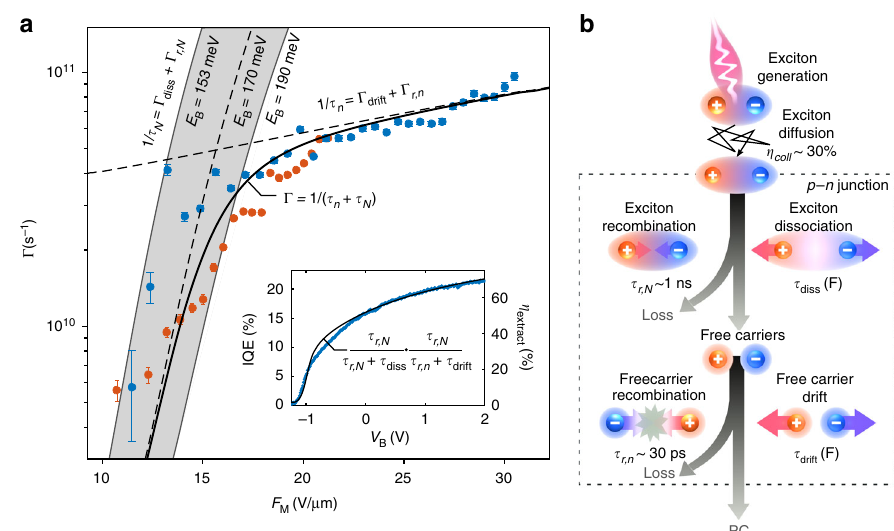
Fig. 4 Dynamic processes governing the photoresponse of monolayer WSe 2 p – n junctions. a Photoresponse rate Γ ¼ 1 τ measured by TRPC (same data as Fig. 3c) vs. maximum in-plane electric fi eld F M calculated for various values of V asym (with V B = 0 V, orange points) and V B (with V asym = 10 V, blue points). ¼ Γ ð F Þ þ Γ ; where τ ¼ 1 = Γ At low fi eld ( F M < 15 V µ m − 1 ), the photoresponse is well described by the total exciton rate Γ N ¼ 1 τ diss M r ; N r ; N r ; N is the exciton N lifetime at zero fi eld ( τ r ; N (cid:3) 1 ns) and Γ diss is the exciton dissociation rate predicted by the 2D Wannier – Mott exciton (see Supplementary Note 4) with a binding energy between E B = 153 and 190 meV (gray shaded curves) and E B = 170 meV (dotted black line). At high fi eld ( F M > 20 V µ m − 1 ), the ¼ Γ ð F Þ þ Γ τ ¼ 1 = Γ photoresponse is governed by the total free carrier rate Γ n ¼ 1 τ drift M r ; n (dotted black line), where r ; n r ; n is the free carrier lifetime at zero n fi eld ( τ (cid:3) 30 ps) and Γ μ = 4 cm 2 V − 1 s – 1 ) drift out of the junction (see Supplementary Note 6). Since r ; n drift is the rate at which carriers (with a mobility exciton dissociation and free carrier drift are consecutive processes, the total photoresponse rate of the device is Γ (cid:4) 1 τ (black solid line). Inset: IQE vs. N þ τ n τ r ; N V V = 10 V extracted from Fig. 1f (left axis, blue data points). Extraction ef fi ciency, η ¼ τ r ; n ; calculated with our model vs. B measured at asym τ r ; n þ τ drift τ r ; N þ τ diss extract V (cid:1) (cid:3) B (right axis, black solid line). b Schematic of the processes contributing to the photoresponse of the device. Excitons are generated by resonant optical excitation and approximatively 30% η of them reach the p – n junction by diffusion during their lifetime τ r ; N : Excitons entering the p – n junctions (black coll dotted box) may either recombine with a time constant τ r ; N or dissociate by tunnel ionization at a rate Γ diss . The resultant free carriers generate a photocurrent as they drift out of the junction at a rate Γ drift , but a fraction is also lost due to their fi nite lifetime τ r ; n . Holes and electrons are represented by red and blue